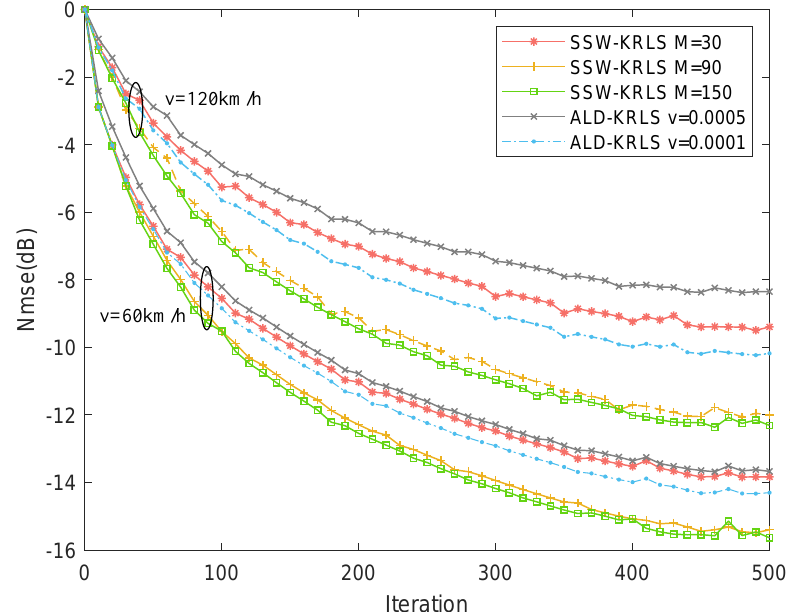
Figure 5. NMSE comparison of the proposed SSW-KRLS algorithm and the ALD-KRLS algorithm. β = 0.97, N t = 64, N r =